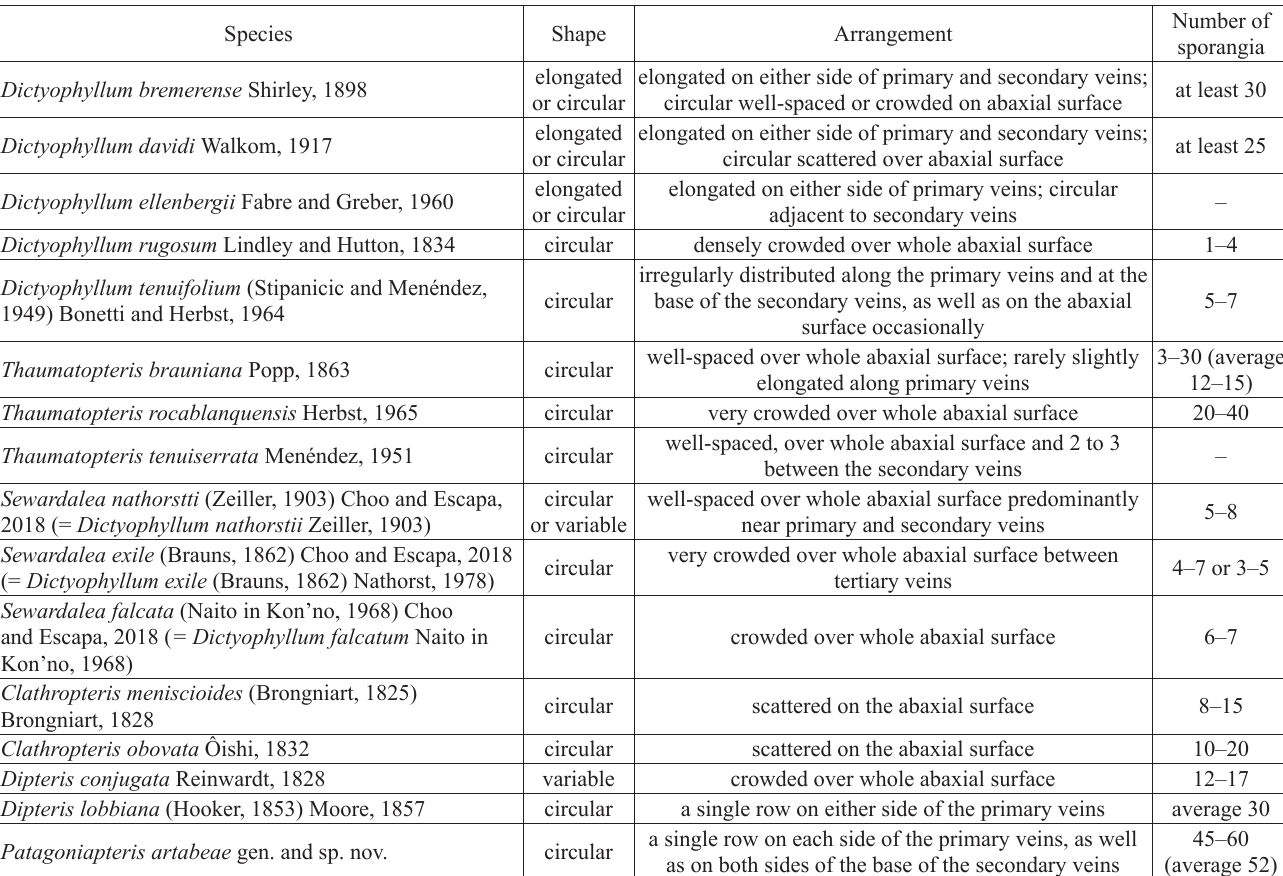
Table 2. Comparison of sori among Dipteridaceae taxa (updated from Ôishi and Yamasita 1936; Webb 1982; Herbst 1992a, b; Guignard et al.